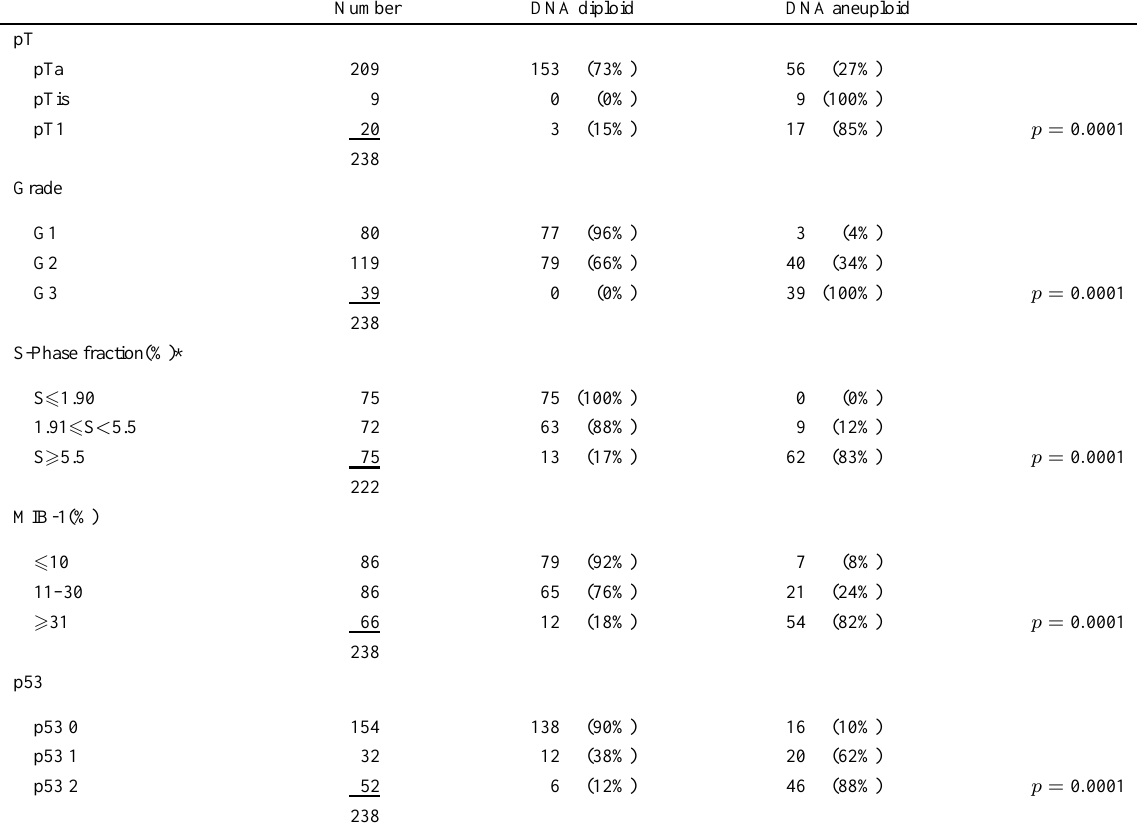
Correlation of DNA ploidy by biparametric DNA/cytokeratin 7 flow cytometry versus clinico-morphologic and biologic parameters DNA